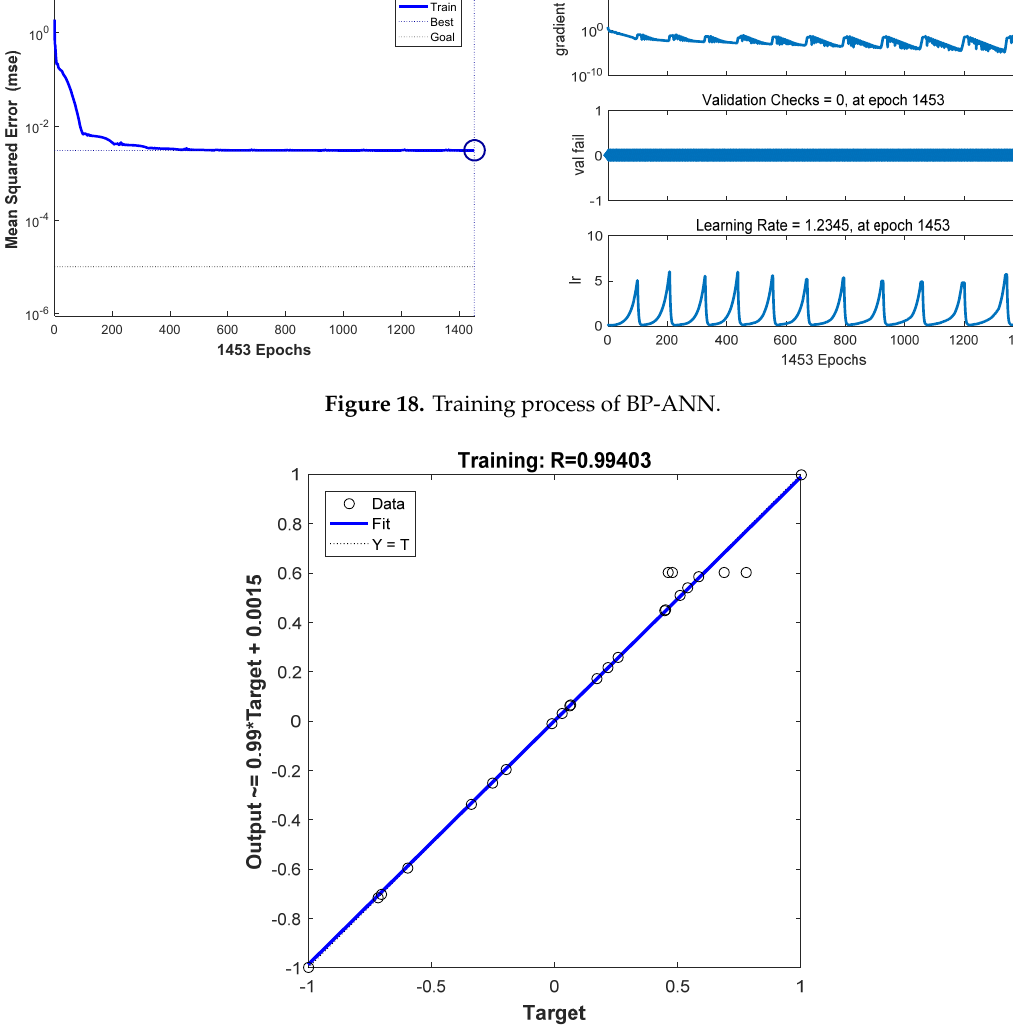
Figure 19. Predicted vs. experimental values of the normalized removal of EV from the BP-ANN.